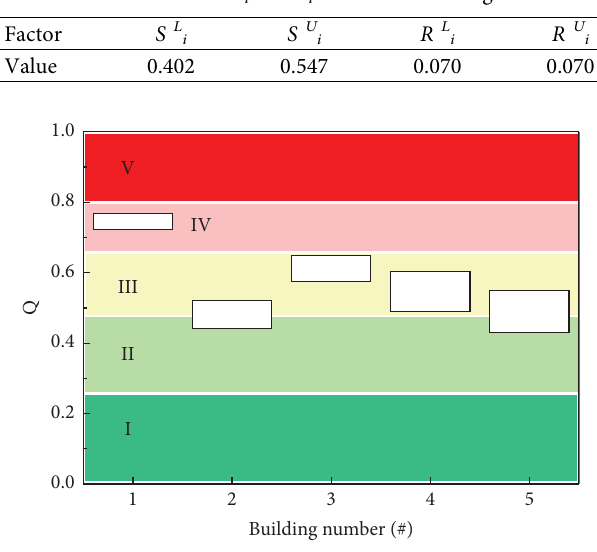
Table 15: Te R i and S i values for buildings.